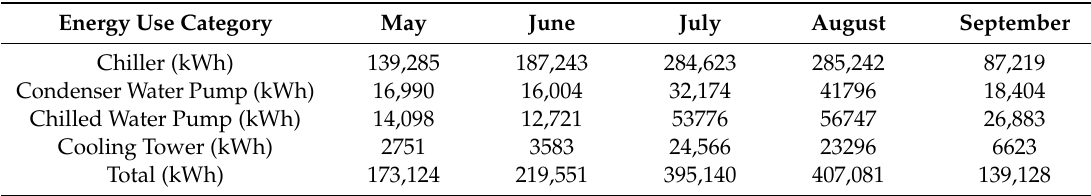
Figure 11. Comparison of the monthly energy use of the main device. Table 7. Monthly energy use of the main device.